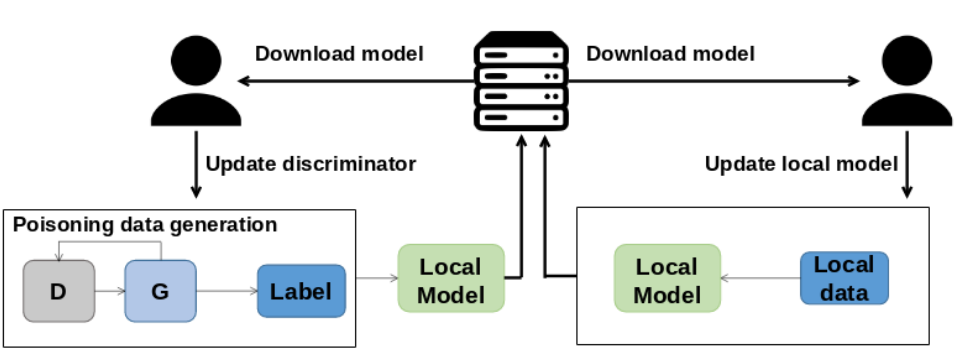
Figure 3. Overview of GAN-based poisoning attack in